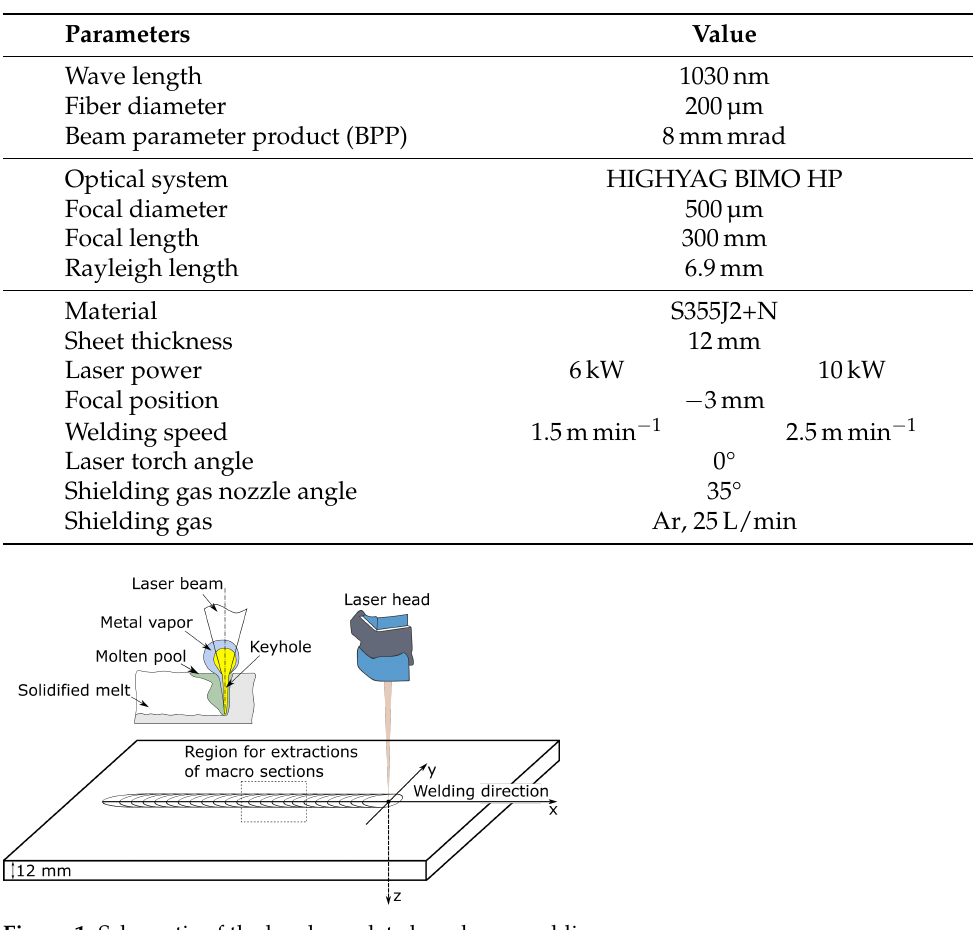
Figure 1. Schematic of the bead-on-plate laser beam welding